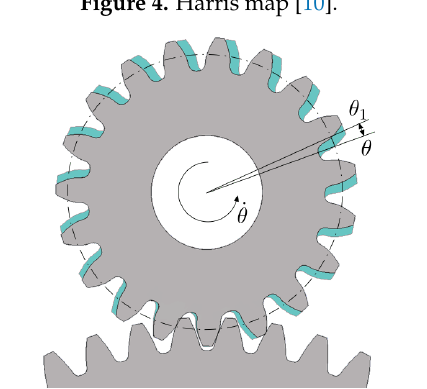
Figure 4. Harris map [10].